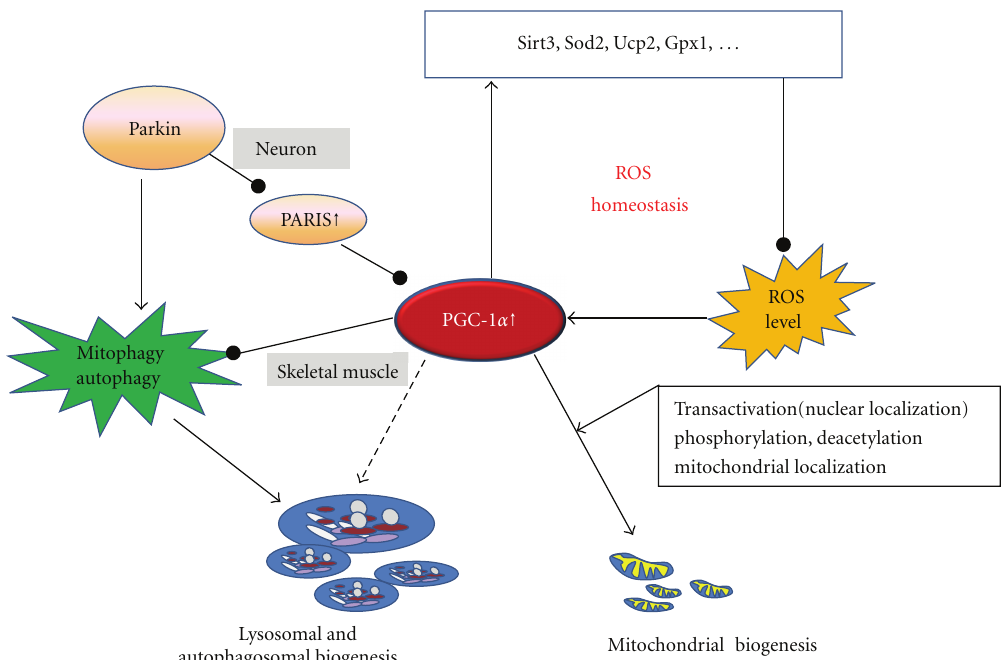
Figure 2: A central role of PGC-1 α in coordinating autophagy and mitochondrial biogenesis. PGC-1 α is a broad and powerful regulator of ROS metabolism and plays a dual role in skeletal muscle by activating autophagosomal biogenesis and preventing the induction of autophagy. Inhibited mitophagy impairs mitochondrial biogenesis via PGC-1 α in neurodegeneration due to Parkin inactivation. PGC-1 α : PPARgamma coactivator 1-alpha; Parkin: an E3 ubiquitin ligase that mediates the ubiquitination of protein substrates in mitophagy induction; PARIS, a zinc finger protein that accumulates in models of Parkin inactivation and in human Parkinson